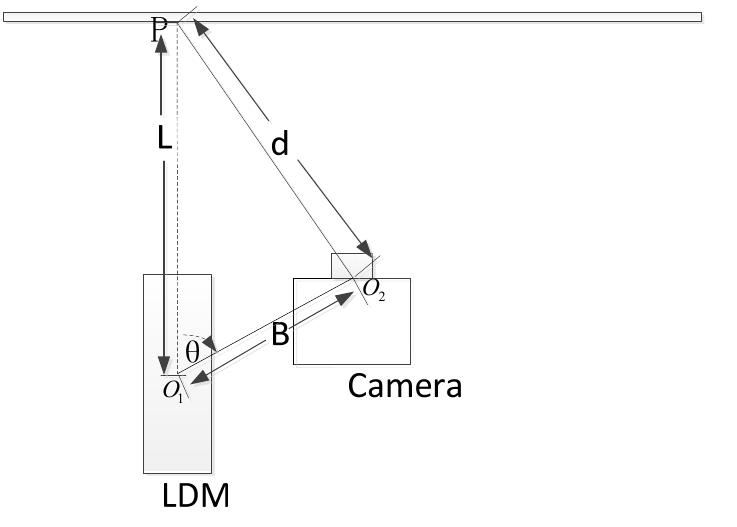
Figure 2. Geometrical relationship of the LDM and the